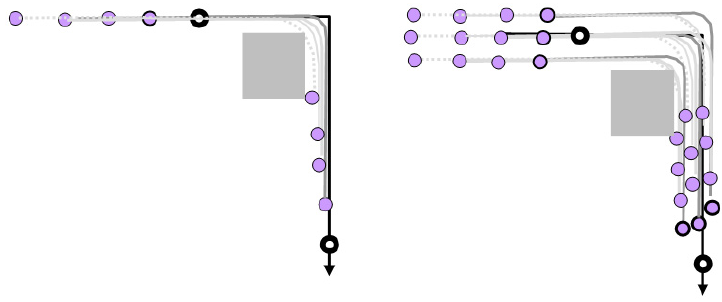
Figure 13. The result of a simulation of array robots following the turning leader.